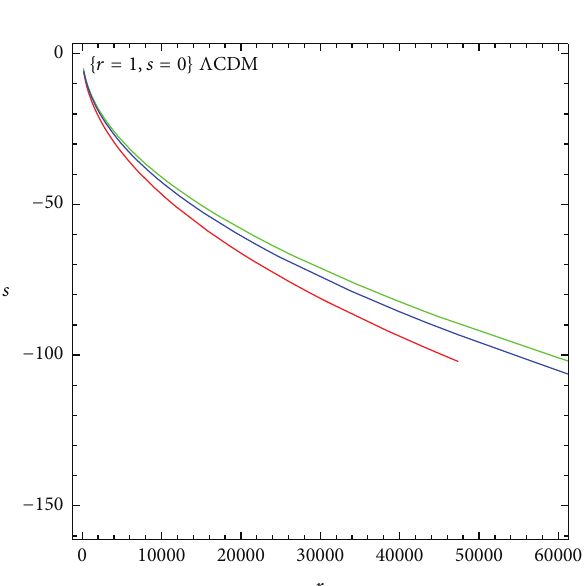
Figure 7: Effective torsion EoS parameter for the Bengochea and Ferraro model.